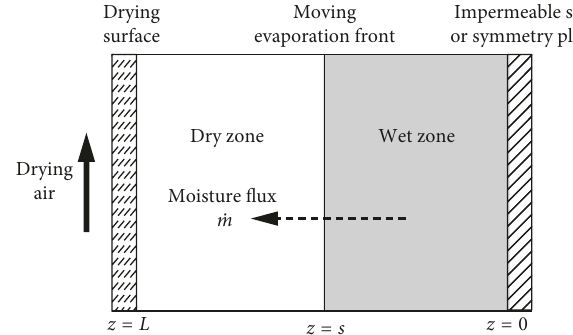
Figure 8: Receding front model for a